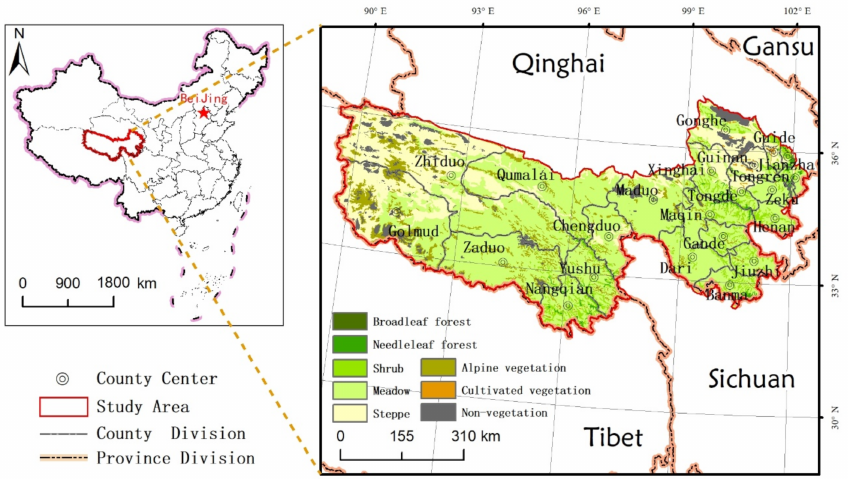
Figure 2. Study area. Vegetation types are extracted from the 1:1,000,000 vegetation map of the People’s Republic of China [34].